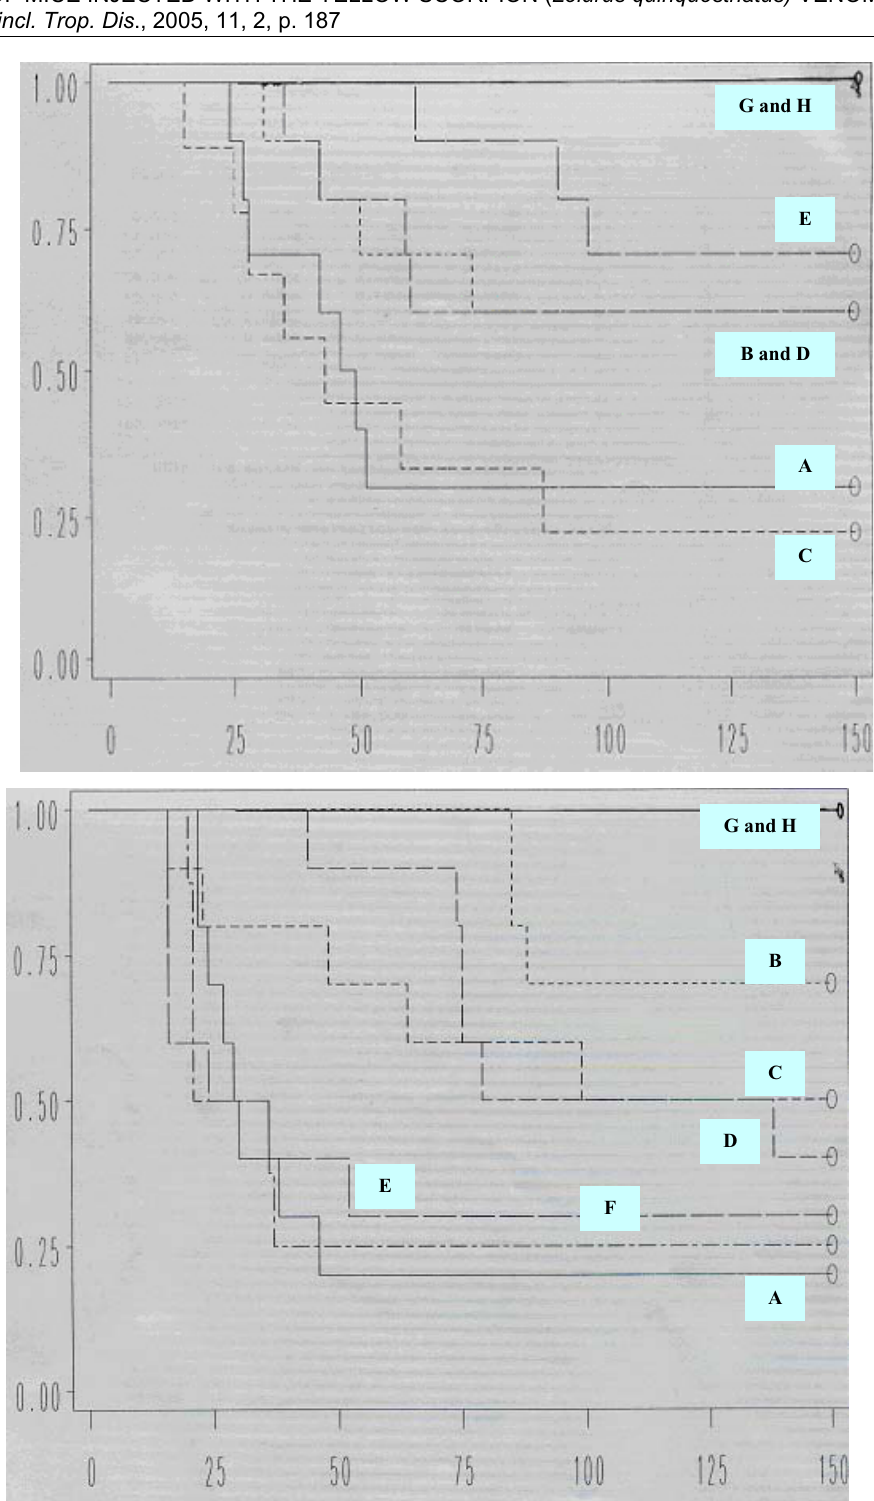
Figure 1. Survival distribution function curves of animals injected with LQQ venom (250 (cid:80) g.kg -1 , s.c.) and lidocaine at a dose of ( I ) 10 mg.kg -1 or ( II ) 15 mg.kg -1 . The Y-axis represents survival distribution, with (0) indicating death and (1) survival, while the X-axis represents survival time in minutes. ( A ) LQQ venom alone, ( B ) Lid admnistered 3 min before, ( C ) 1 min, ( D ) 5 min, ( E ) 15 min, and ( F ) 20 min after LQQ venom. As control, ( G ) Lid and ( H ) 0.9%NaCl were administered alone